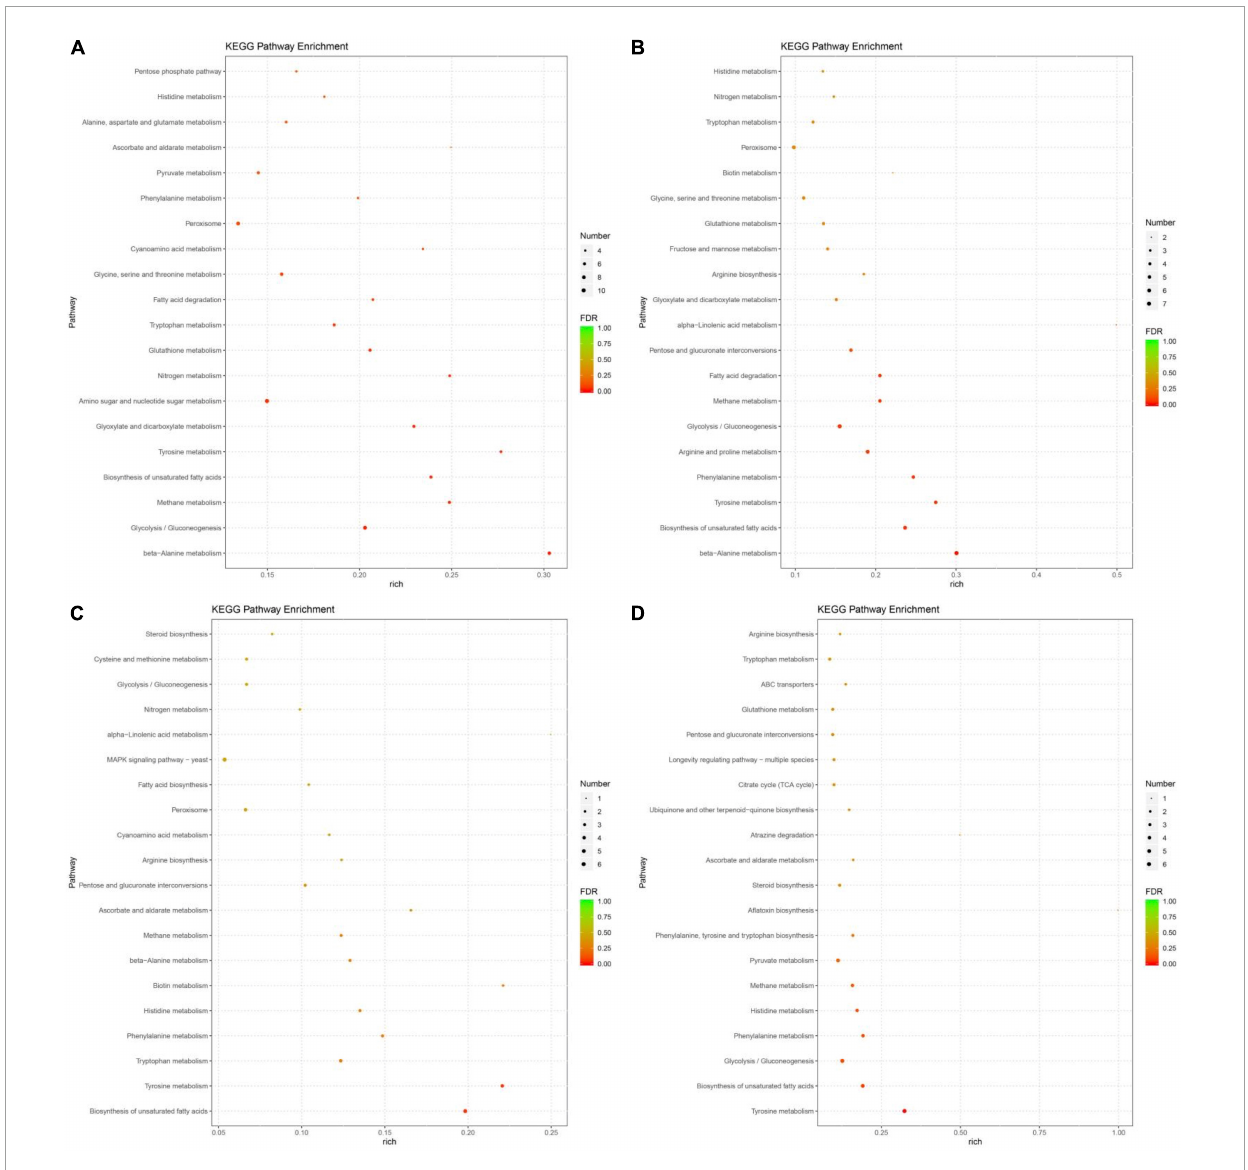
FIGURE4 The most significantly-enriched kyoto encyclopedia of genes and genomes (KEGG) pathway of differentially expressed genes (DEGs) in 30P_110P (A) , 50P_110P (B) , 70P_110P (C) , and 90P_110P (D)